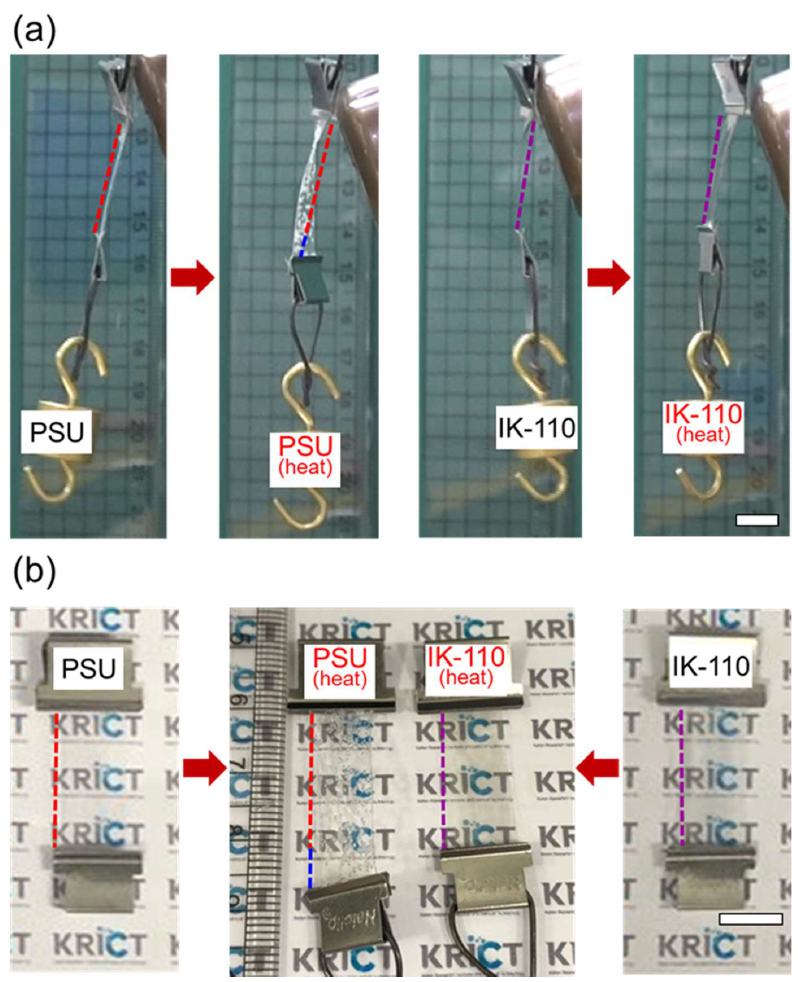
Figure 7. ( a ) Thermal dimensional stability experiment by heat-gun, and ( b ) photographs of PSU and IK-100 films before and after heat exposure to 200 °C for 2 min (scale bar: 1 cm).